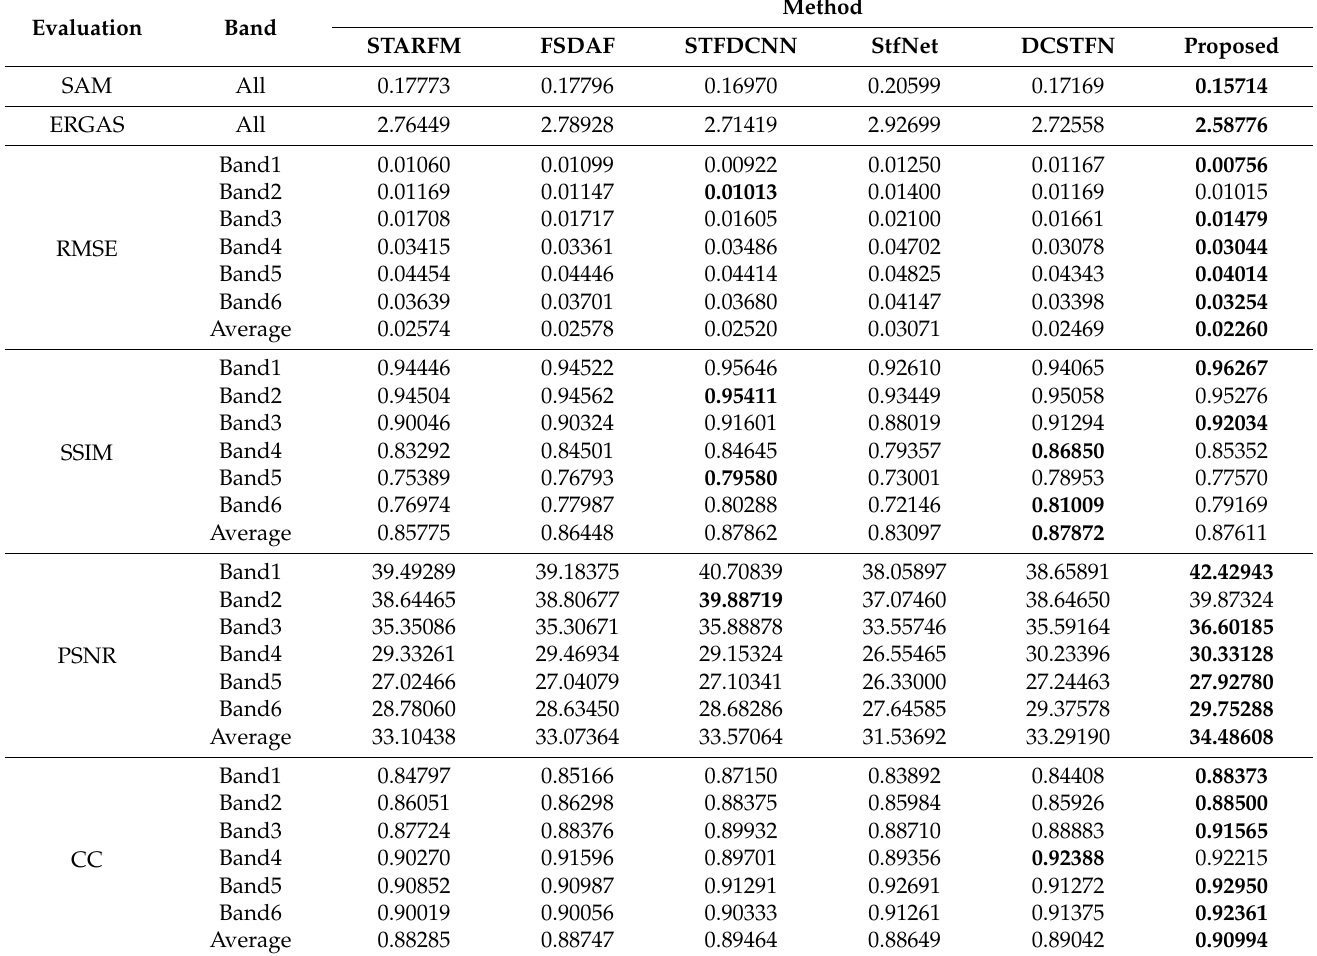
Table 1. Objective metrics of different fusion methods for the CIA